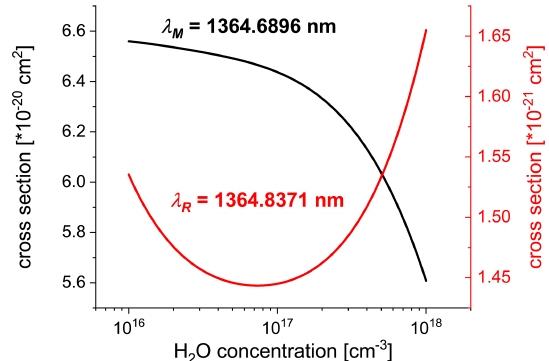
Figure 4. Dependence of σ M and σ R on water vapour concentra- tion. Data extracted from the HITRAN database ( p = 1000hPa, T = 23 ◦